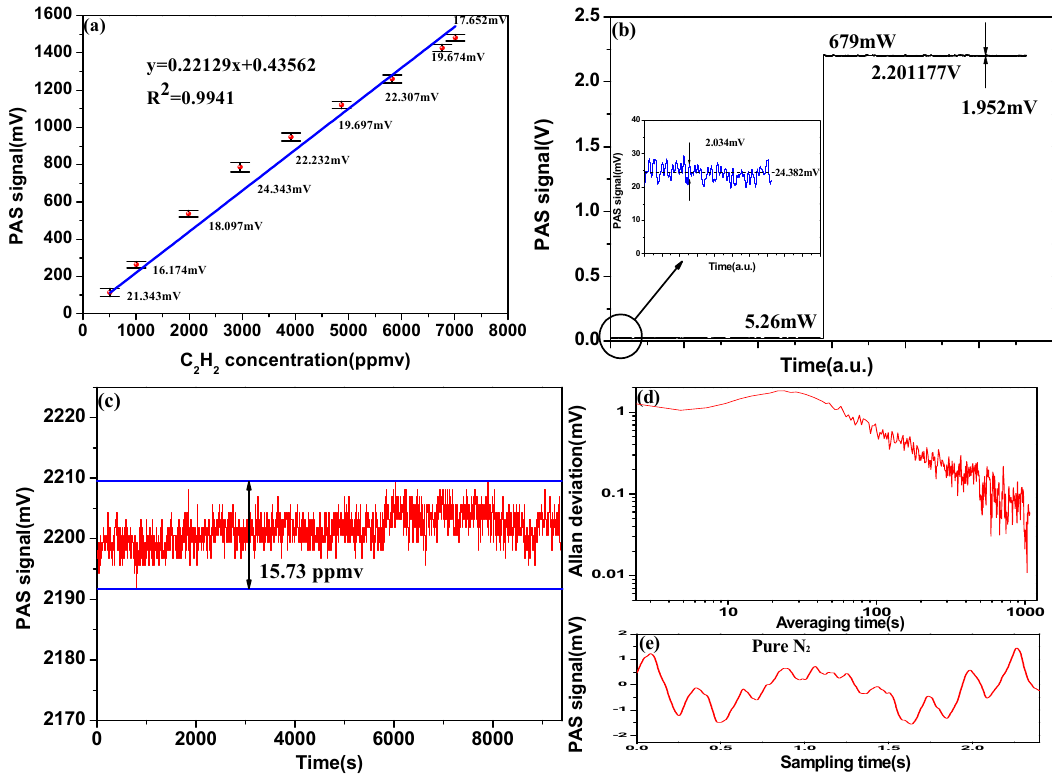
Figure 5. ( a ) Linearity of the PAS signal to the C 2 H 2 concentration at 1 bar and room temperature (24 °C); ( b ) The PAS signal in conventional intensity modulation system and acousto-optic Q-switched system; ( c ) Long-term stability of acousto-optic Q-switched system for 9500-ppmv C 2 H 2 ; ( d ) Allan deviation analysis of the acousto-optic Q-switched system as a function of integration time, the measurement was carried out with the PAS cell filled with pure N 2 ; ( e ) The representative PAS signals for pure N 2 .